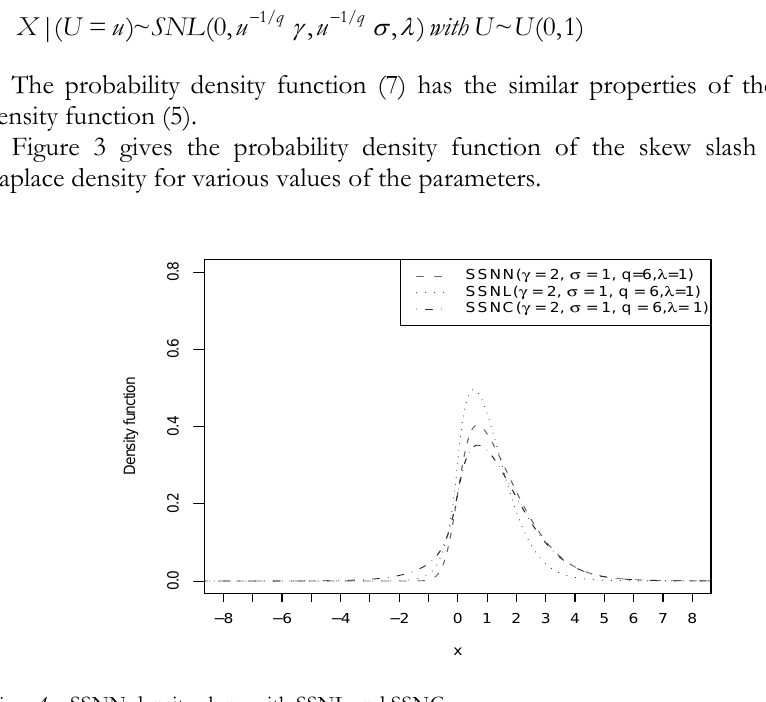
Figure 4 – SSNN density along with SSNL and